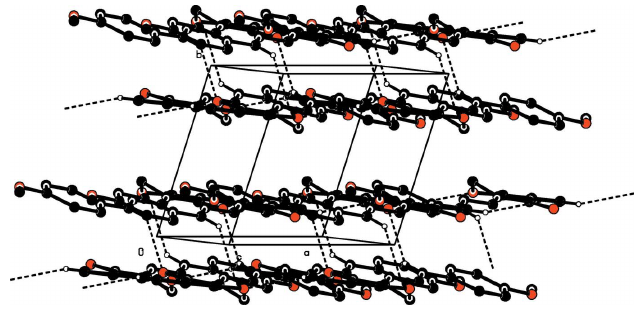
Figure 2 The packing of the molecules in the crystal structure. The dashed lines indicate hydrogen bonds.